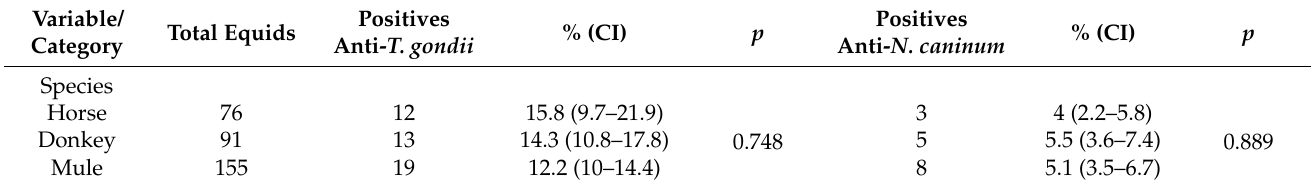
Table 1. Prevalence of anti- Toxoplasma gondii and anti- Neospora caninum antibodies in urban traction horses, donkeys and mules in the semi-arid region of Northeast Brazil.